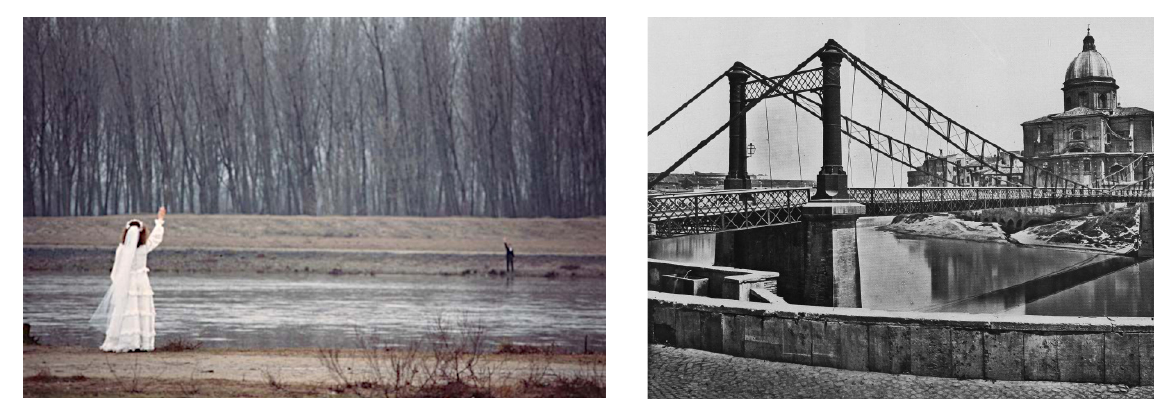
Figure 3. The suspension bridge near to the Church of San